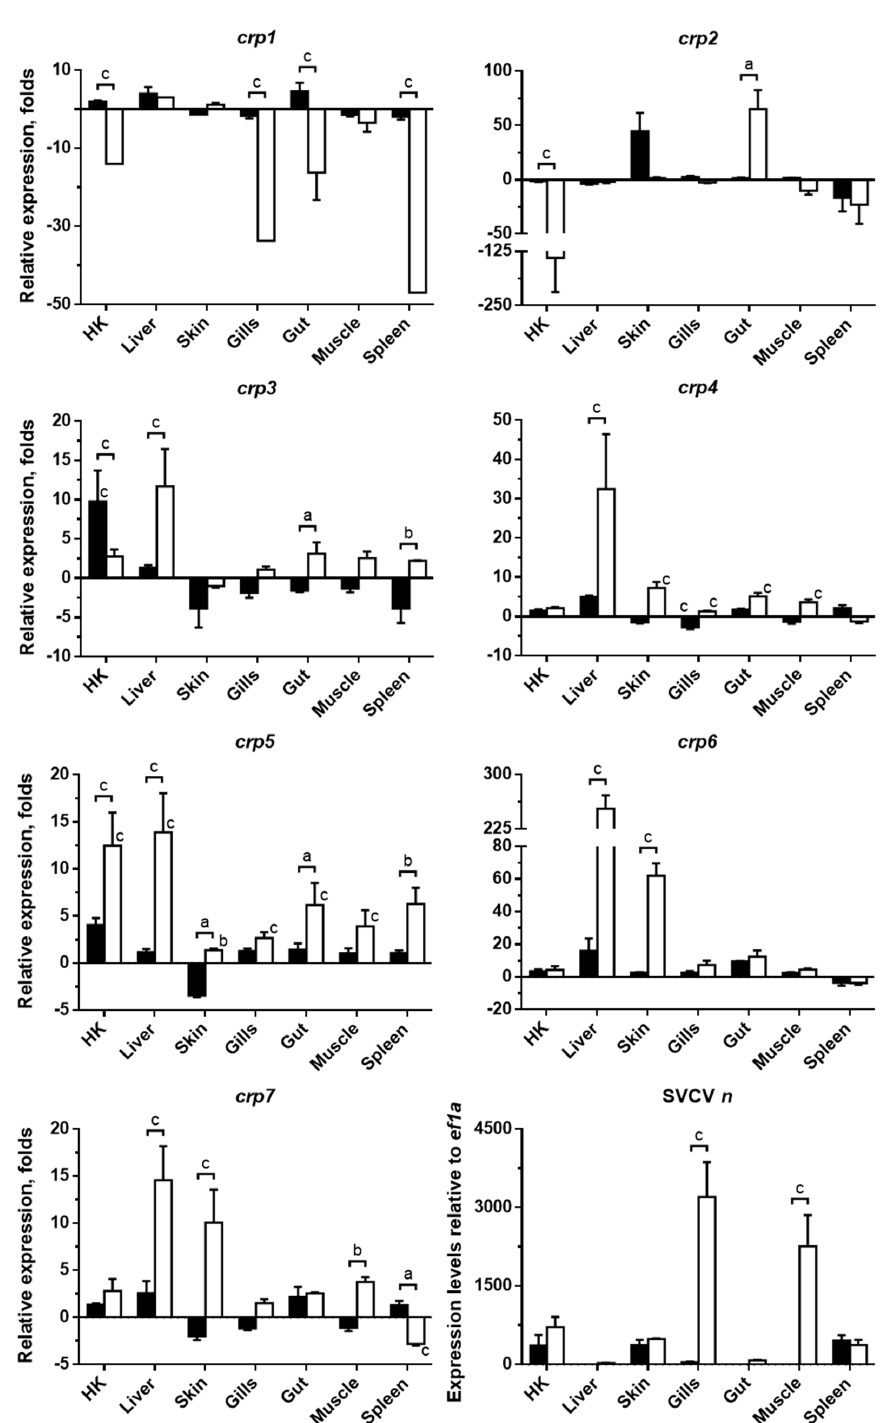
Figure 2. Expression modulation of crp1 – 7 in zebrafish tissues in response to spring viremia of carp virus (SVCV) infection. The transcription levels of crp1 – 7 and SVCV n in tissues from SVCV-infected zebrafish at 2 and 5 dpi (black and white bars, respectively) were quantified by RT-qPCR. ef1a mRNA was used as the endogenous control in all cases. crp1 – 7 transcription levels were also normalized to the values obtained from the corresponding samples in non-infected fish. Data are represented as the mean fold changes ± SD for crp s and as the mean relative expression level ± SD for SVCV n (four different individuals in all cases). Significant differences were determined by two-way ANOVA and Sidak’s multiple comparison test. Statistical differences between the 2- and 5-dpi groups are represented by keys together with a, b, and c letters on top. Statistical differences between the 2- or 5-dpi groups and the non-infected group are represented by a, b, and c letters just on top of the corresponding bars. a, p ≤ 0.05; b, p ≤ 0.01; c, p ≤